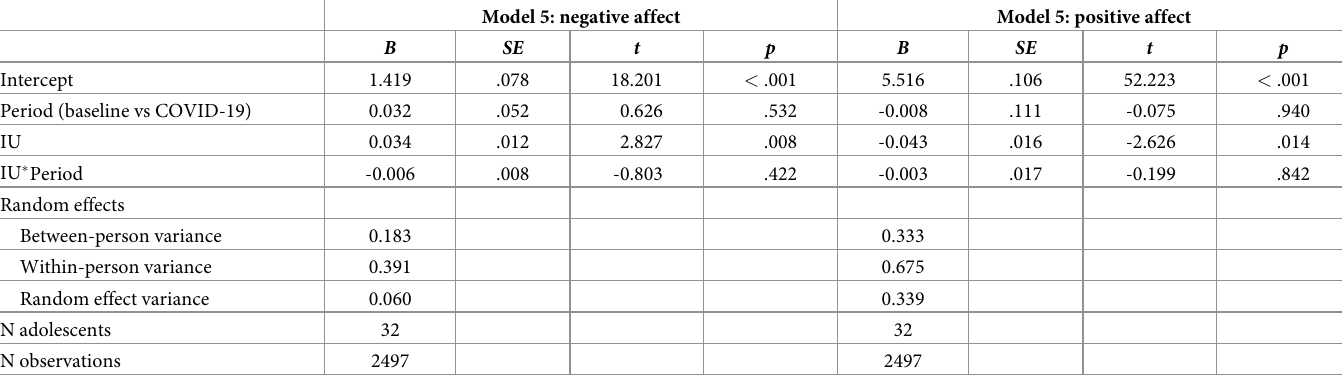
Table 3. Results of final model 5 on the relation between period and affect and the moderating role of intolerance of uncertainty in adolescents. Model 5: negative affect Model 5: positive